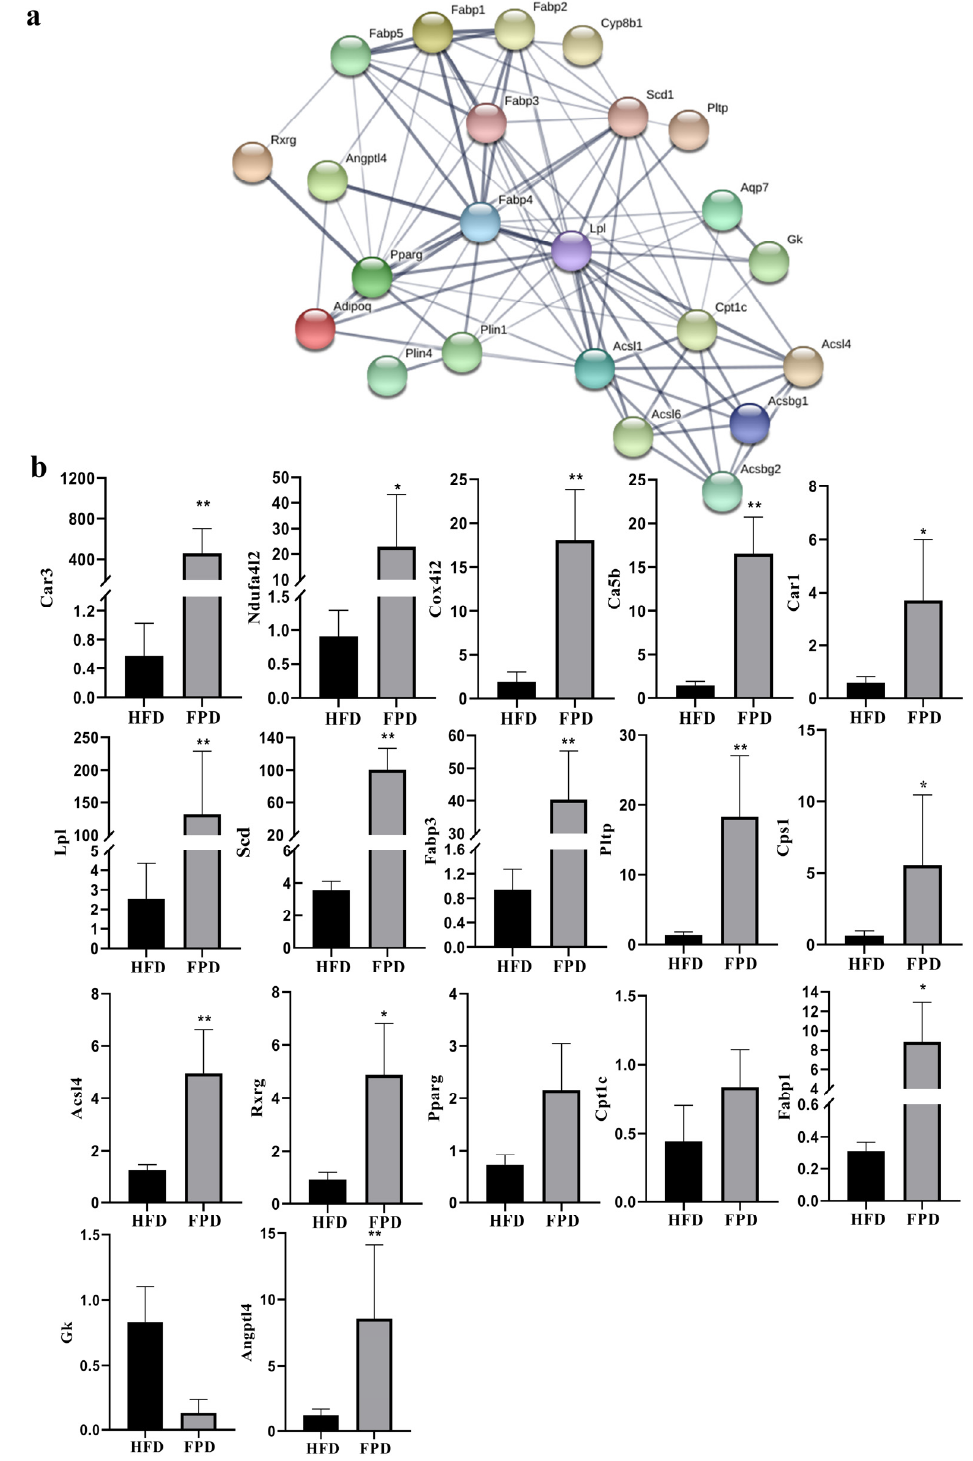
Figure 5. PPI network and qRT-PCR verification of DEGs. ( a ) PPI network of 23 DEGs in the PPAR-signaling pathway. The nodes represent the proteins (genes), and the edges represent the interactions of proteins; ( b ) qRT-PCR verification of DEGs in the PPAR-signaling pathway and energy-metabolism pathway. ** means p < 0.01. * means p < 0.05. DEGs, differentially expressed genes; HFD, Group HFD, rats were fed D12492 during the establishment of the obesity model and then fed AIN-93M; FPD, Group FPD, rats were fed D12492 during the establishment of the obesity model and then fed an FP-containing diet.